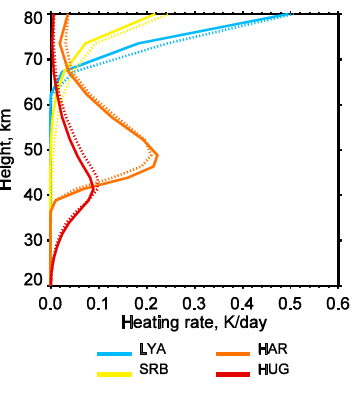
Figure 4. Shortwave heating rate differences of the 11-year solar cycle (solar max minus solar min) in Kday − 1 for tropical standard atmosphere and solar zenith angle equal to 10 ◦ calculated by extra heating parameterizations and libRadtran. Solid lines: results of pa- rameterizations. Dotted lines: libRadtran results for the same spec- tral intervals (Table 1).